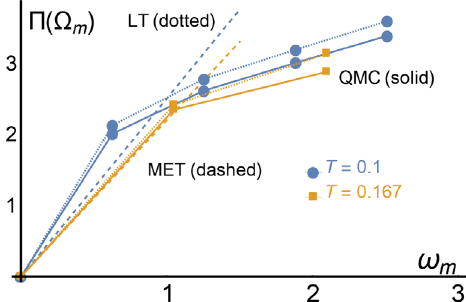
Þ in the Ising-nematic m